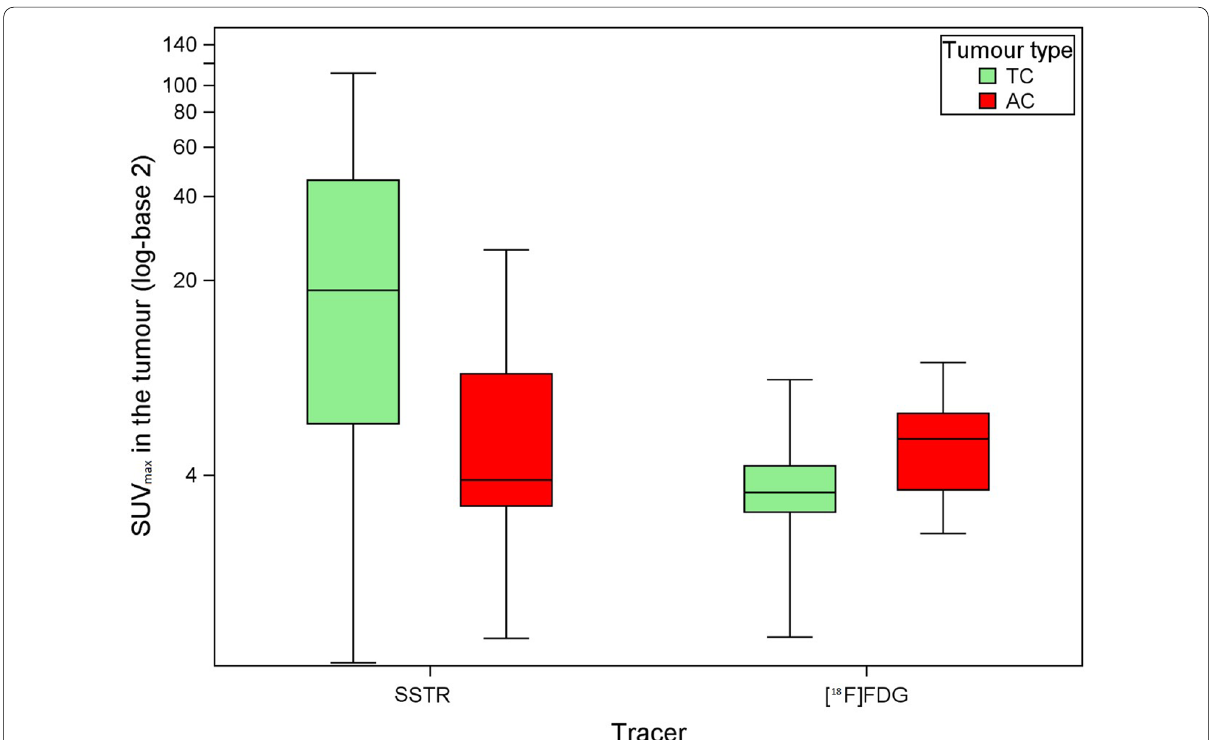
Fig. 1 Box plots of the distribution of SUV max values in function of tracer and tumour type, yielding a median SUV max on SSTR PET/CT of 18.4 and 3.8 for 52 typical bronchial carcinoid tumours and 12 atypical bronchial carcinoid tumours, respectively, and a median SUV max on [ 18 F]FDG PET/CT of 3.5 and 5.4 for 28 typical bronchial carcinoid tumours and 9 atypical bronchial carcinoid tumours,